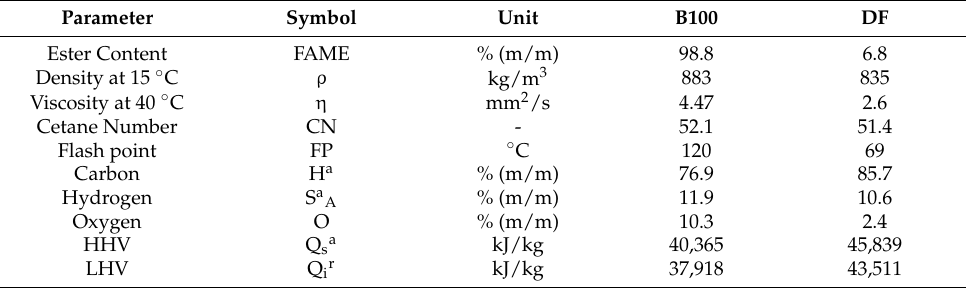
Table 2. Selected physicochemical properties of diesel fuel and methyl esters rape oil.